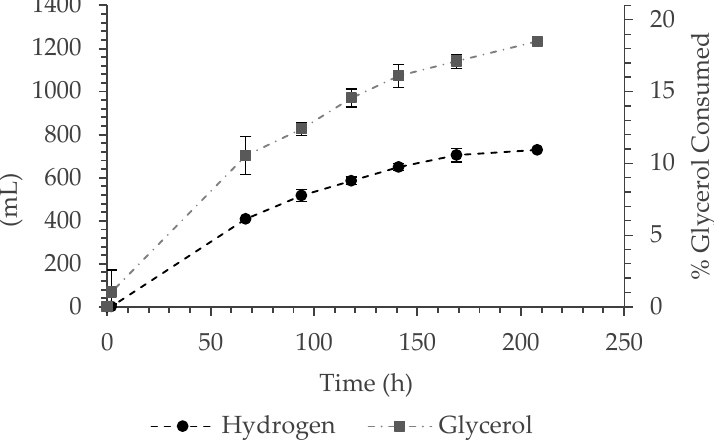
Figure 2. Time profiles of cumulative hydrogen production and glycerol consumption (cooling water temperature of 21 ◦ C, light intensity of 500 W m − 2 , and biomass concentration of 1.22 g L − 1 ). Conversely, the regression model predicted a maximum production rate per biomass concentration of 0.21 mmol g CDW − 1 h − 1 at a light intensity of 600 W m − 2 and biomass concentration of 0.40 g L − 1 . At this biomass concentration, the model predicted a maximum rate of hydrogen production, which also compares well with the experimentally measured value of 0.185 mmol g − 1 h − 1 .